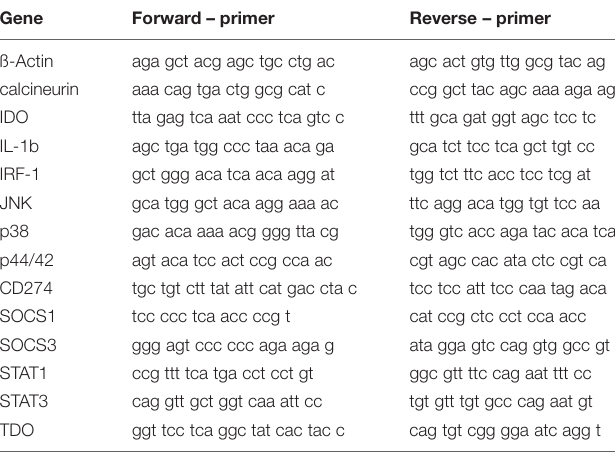
Frontiers in Microbiology |